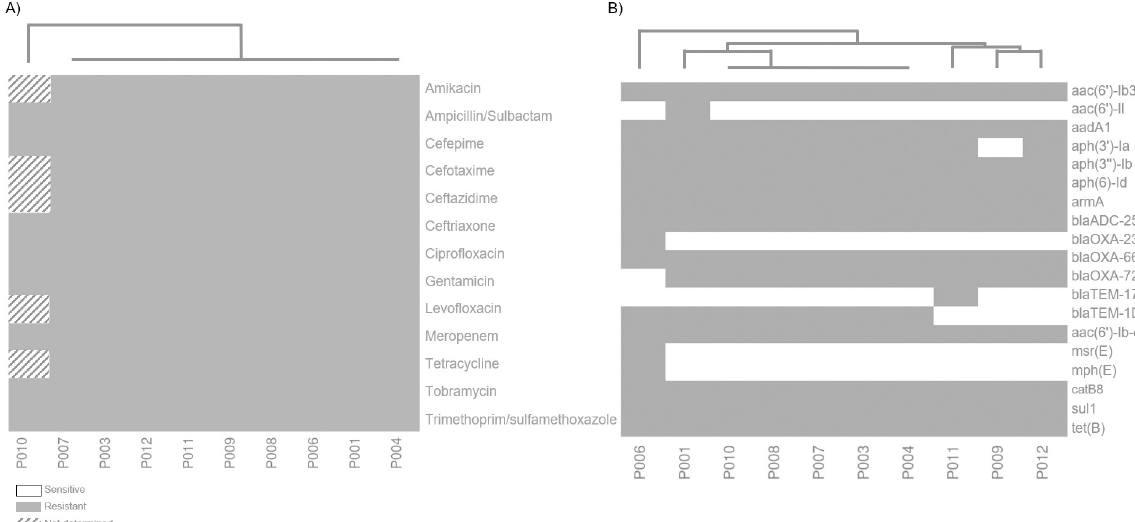
Fig 2. Antibiotic resistance profile. A) All strains were subjected to antibiotic resistance testing using amikacin, ampicillin/sulbactam, cefepime, cefotaxime, ceftazidime, ceftriaxone, ciprofloxacin, gentamicin, levofloxacin, meropenem, tetracycline, tobramycin and trimethoprim/sulfamethoxazole. Two distinctive patterns were observed. All samples exhibited the same profile. Sample P010 had an incomplete antibiotic resistance testing; and therefore, could not be classified accordingly. B) Drug resistance mutation detection was inferred from WGS. Six distinctive patterns were